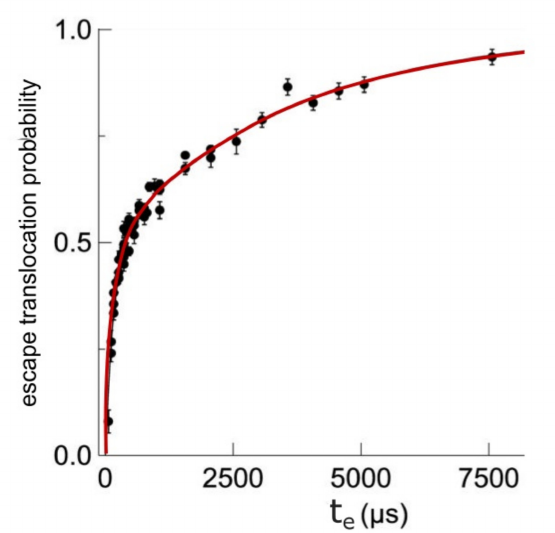
Figure 5. Escape translocation probability as a function of escape